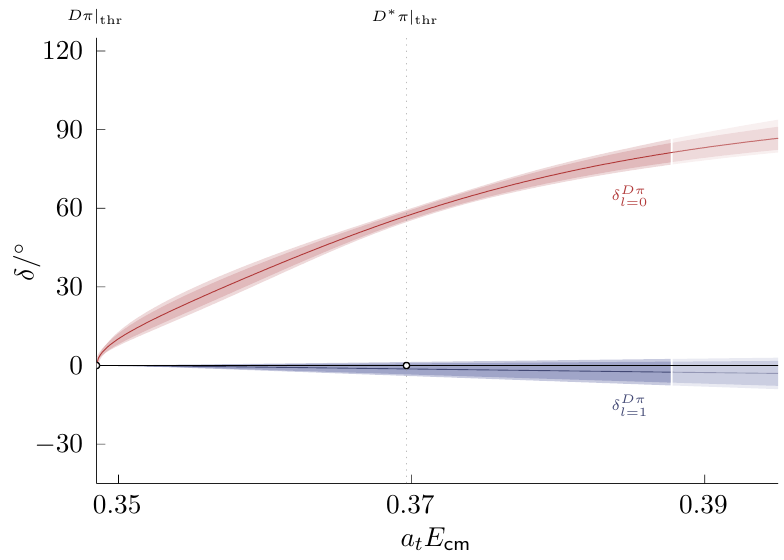
Figure 7. Phase shift of the S -wave (red) and P -wave (blue) Dπ amplitudes. The inner line corresponds to the reference parameterisation. The inner dark error band represents the statistical error from the χ 2 -minimisation while the outer light error band additionally includes uncertainties from varying the input hadron masses and anisotropy within 1 σ